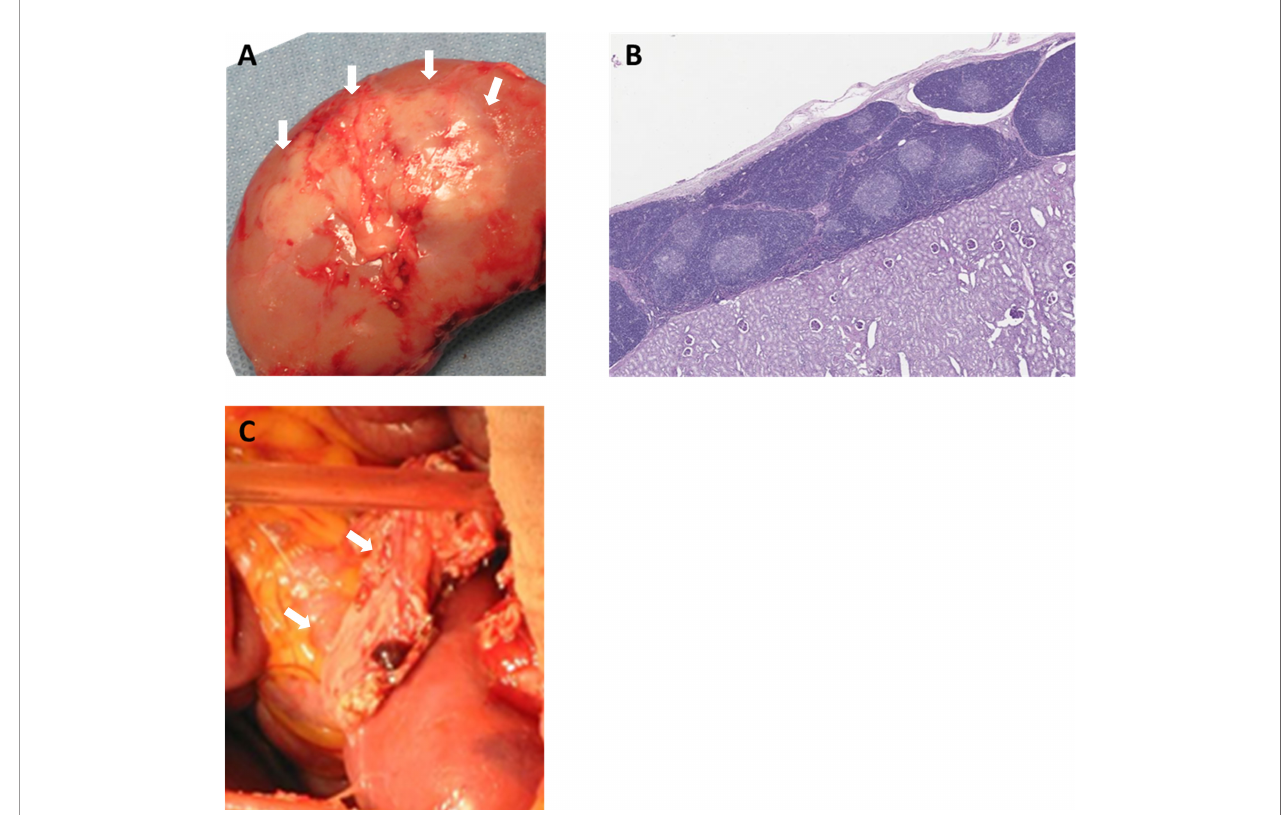
FIGURE 1 | Vascularized donor thymic graft transplantation. (A) Porcine composite “ thymokidney ” at 5 weeks after thymic tissue implantation under own renal capsule, and (B) histology of the thymokidney (HE). (C) Co-transplantation of porcine vascularized thymic lobe and kidney graft in a baboon. White arrows indicate thymic